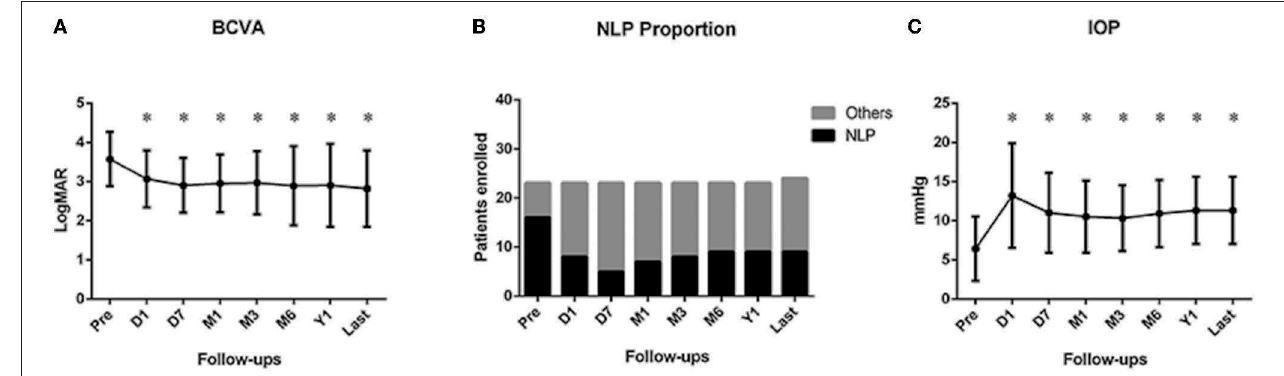
FIGURE 3 | Changes of best-corrected visual acuity (BCVA), intraocular pressure (IOP), and proportion of NLP at each follow-up. (A) Compared with the preoperative BCVA, a significant improvement in LogMAR BCVA was observed at each follow-up after vitrectomy (all with p < 0.05), (B) Proportion of NLP was observed to be reduced from before surgery at each follow-up. (C) Compared with the preoperation, IOP at each postoperative follow-up was significantly increased (all with p < 0.05). Pre: preoperation; D1: 1 day after vitrectomy; D7: 1 week after vitrectomy; M1: 1 month after vitrectomy; M3: 3 months after vitrectomy; M6: 6 months after vitrectomy; Y1: 1 year after vitrectomy; last: last follow-up. * p < 0.05 compared with